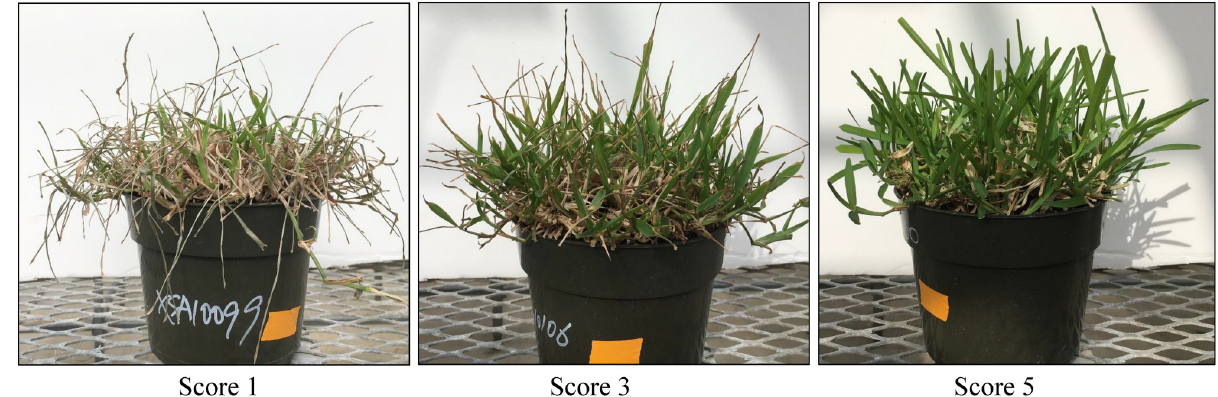
Fig 1. Visual rating of leaf firing score (1–5) on St. Augustinegrass Raleigh x Seville F 1 population during drought stress in greenhouse trails.